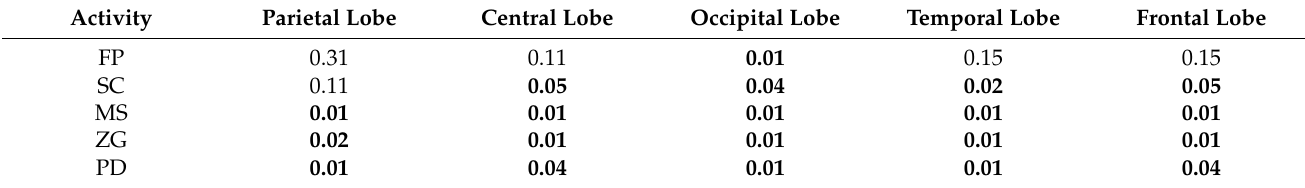
Table 9. Wilcoxon paired test: p -value results of beta band absolute power between the control test opened eyes (OE) and each of the games (Finger Painting (FP), Sorting Cubes (SC), More Switches (MS), Zero Gravity Switches (ZG), and Punch the Dummy (PD)).